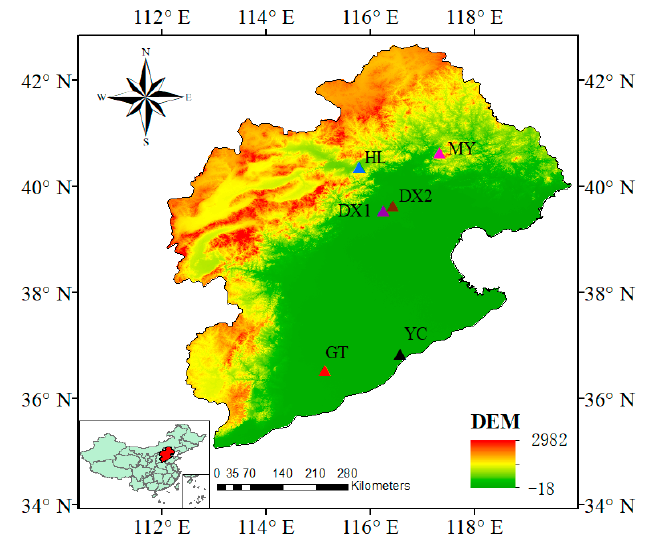
Figure 1. Distribution of the six flux tower sites in the study area and the topographic characteristics of HRB. Daxing1 (DX1), Daxing2 (DX2), Guantao (GT), Huailai (HL), Miyun (MY) and Yucheng (YC).